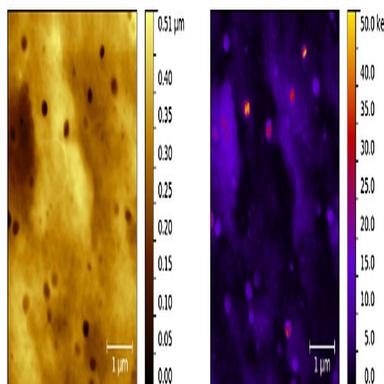
Topography (left) and dissipation energy (right) AFM nanomechanical mappings of the PBAT/il-TMP blend, revealing the dissipative nature of the nodules.